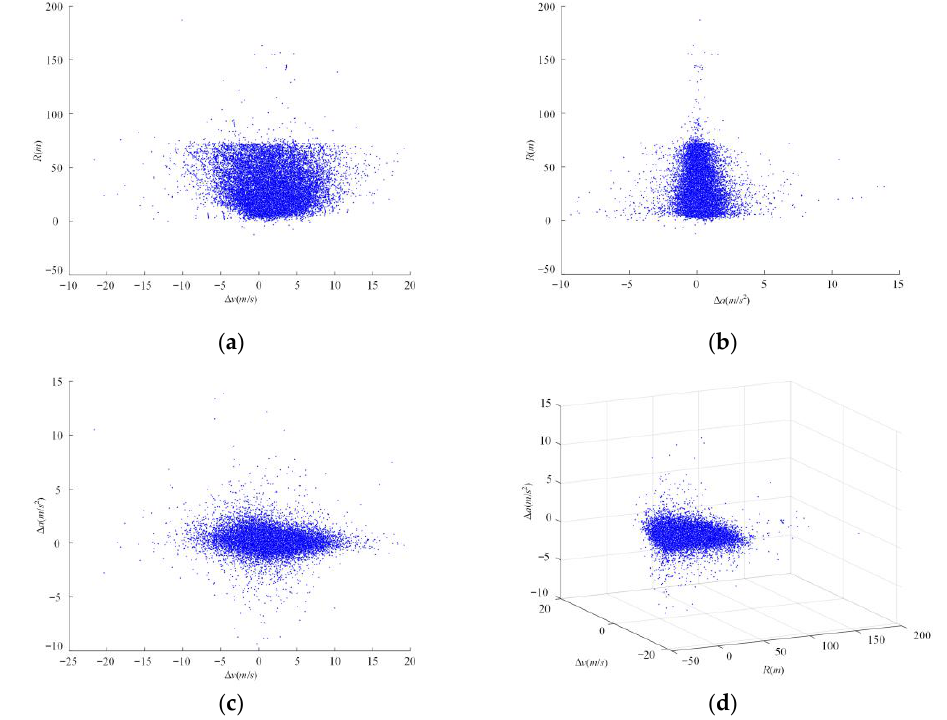
Figure 11. The distributions of 26214 cut-in scenarios obtained from the NDD. ( a ) The joint distri- bution of R and ∆ v between the ego vehicle and the object vehicle at the critical moment of cut-in scenarios; ( b ) the joint distribution of R and ∆ a between the ego vehicle and the object vehicle at the critical moment of cut-in scenarios; ( c ) the joint distribution of ∆ a and ∆ v between the ego vehicle and the object vehicle at the critical moment of cut-in scenarios; ( d ) the joint distribution of R , ∆ v and ∆ a between the ego vehicle and the object vehicle at the critical moment of cut-in scenarios.